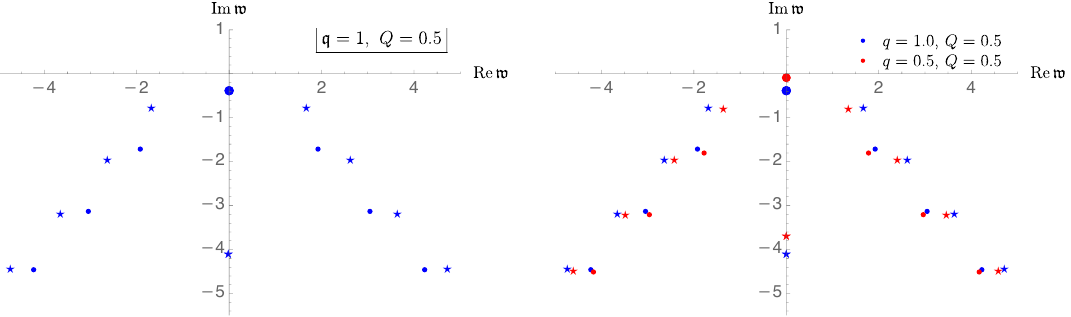
Figure 3. Left panel: stars are poles of the transverse master momentum density Green’s function and dots correspond with the poles of the transverse master charge current Green’s function. In fact, dots identify the shear poles. As q decreases, all poles stay at a (cid:12)nite distance from the real axis, except for the one marked with a large dot. The latter manifests the existence of a di(cid:11)usive shear mode in the boundary N = 4 SYM theory at (cid:12)nite chemical potential.